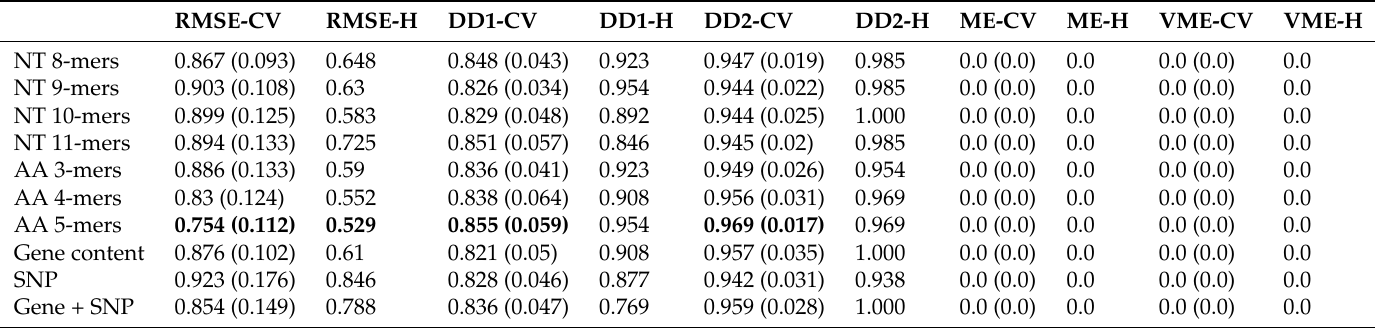
Table A28. N. gonorrhoeae